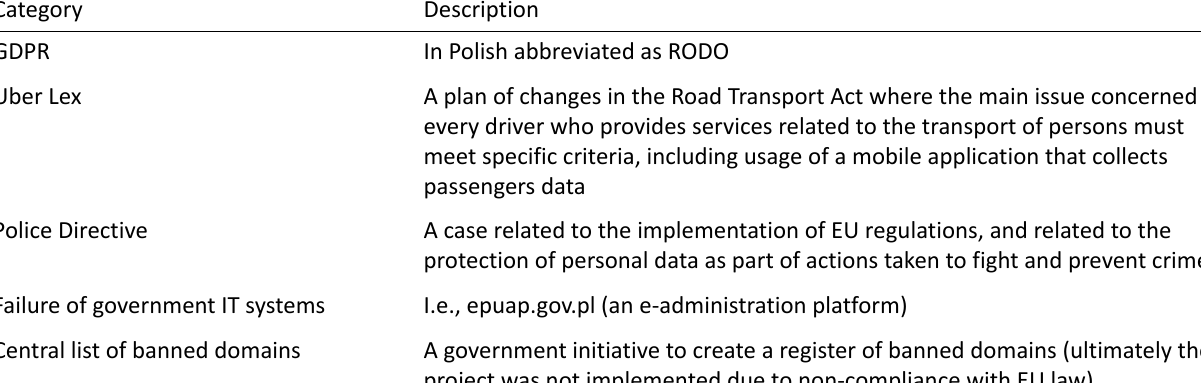
Table 1. Issue-oriented categories.